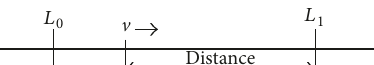
negative, the variable keeps its direction as inc or dec, respectively. If a function is the derivative between value couples defined as [𝑎, 𝑏] , 𝑎 and 𝑏 are defined as landmark